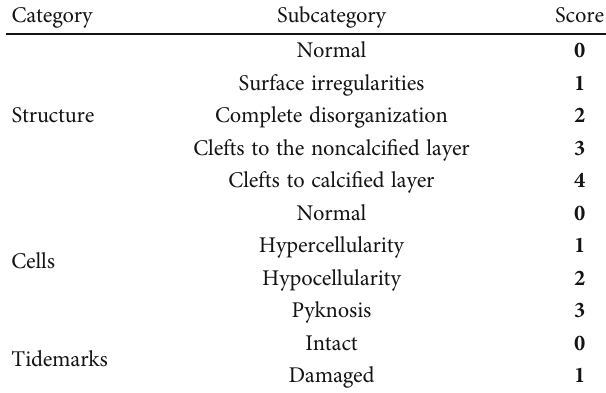
Table 2: The modi fi ed Mankin score of microscopic observation of OA articular